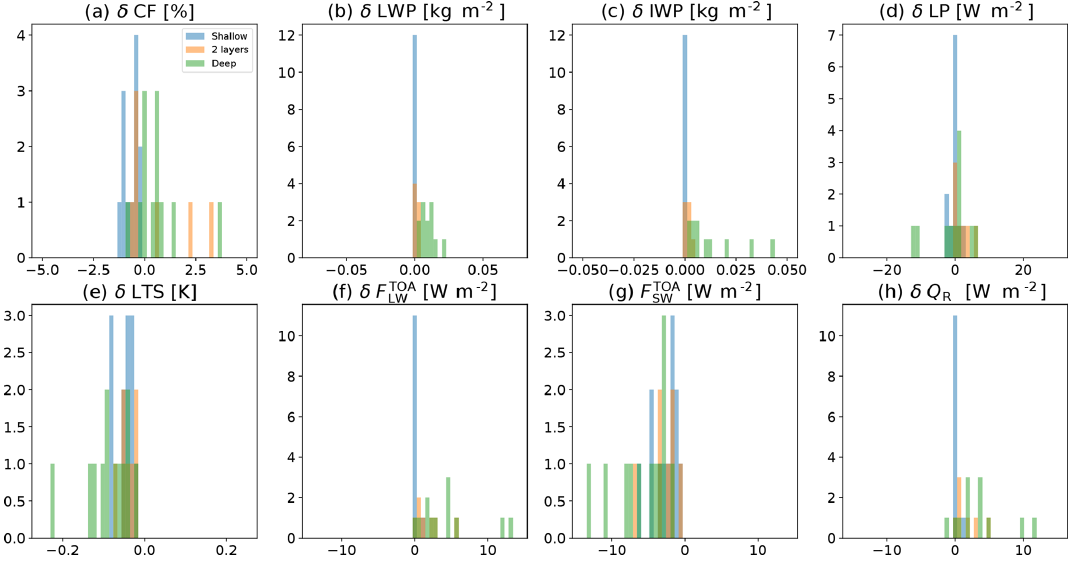
Figure 9. Same as Fig. 8 but for the NARVAL 2 month (August